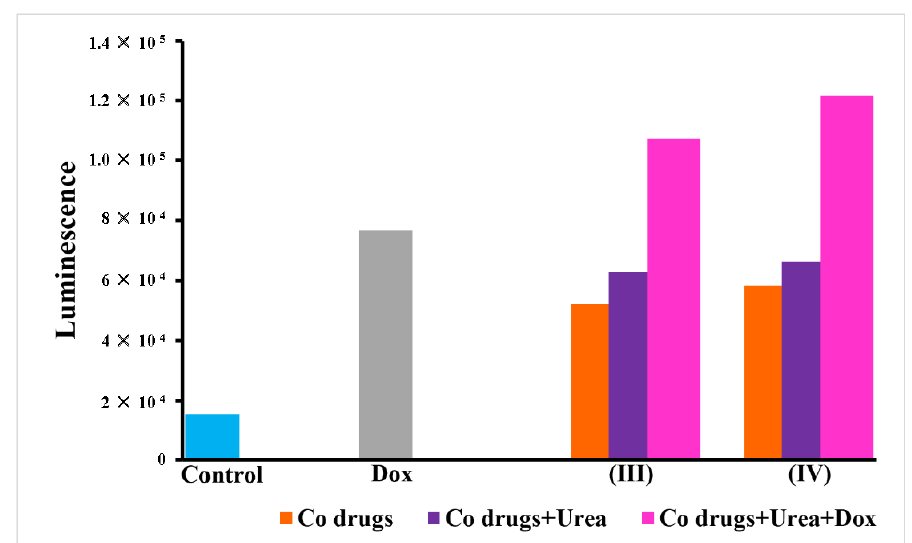
Figure 7. Caspase 3/7 activity in treated A549 cells. The figure shows comparative caspases activity in A549 cells treated with doxorubicin alone and in combination with cobalt complexes and urea. An increase in luminescence and thus enhanced caspase 3/7 activity is clear in the combination